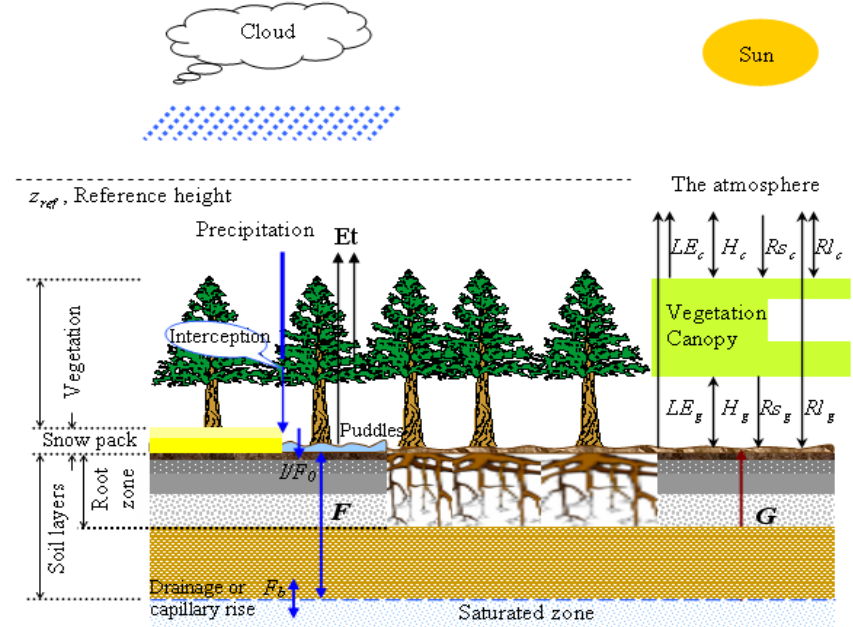
Figure 4. Structure of the EASS model. Three components (soil, vegetation and the atmosphere) are considered in EASS, which are integrated with two interfaces. The right panel illustrated energy fluxes between these three components. LE , H , Rs , Rl , and G are the latent heat flux, sensible heat flux, shortwave radiation, longwave radiation, and soil conductive heat flux, respectively; the subscripts g and c present the energy fluxes at soil- canopy and canopy-atmosphere interfaces, respectively. The left panel describes soil water fluxes. The symbol F represents conductive water flux between soil layers, and F 0 represents the incoming water flux from the surface to the top soil layer (i.e., the actual infiltration rate I ), and F is the water exchange (drainage or capillary rise) between the b bottom soil layer and the underground water